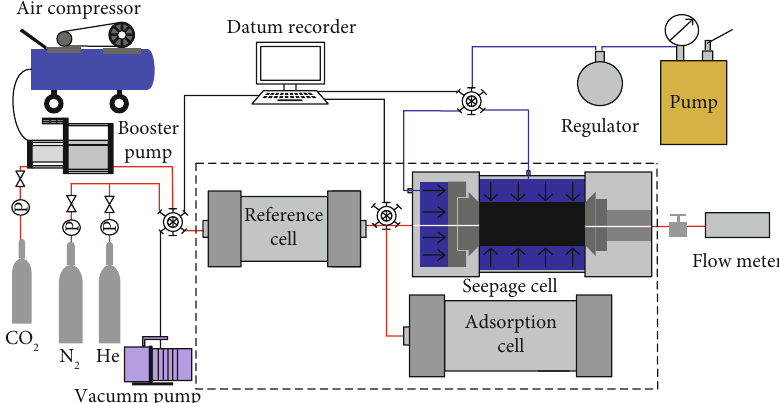
Figure 2: Experimental